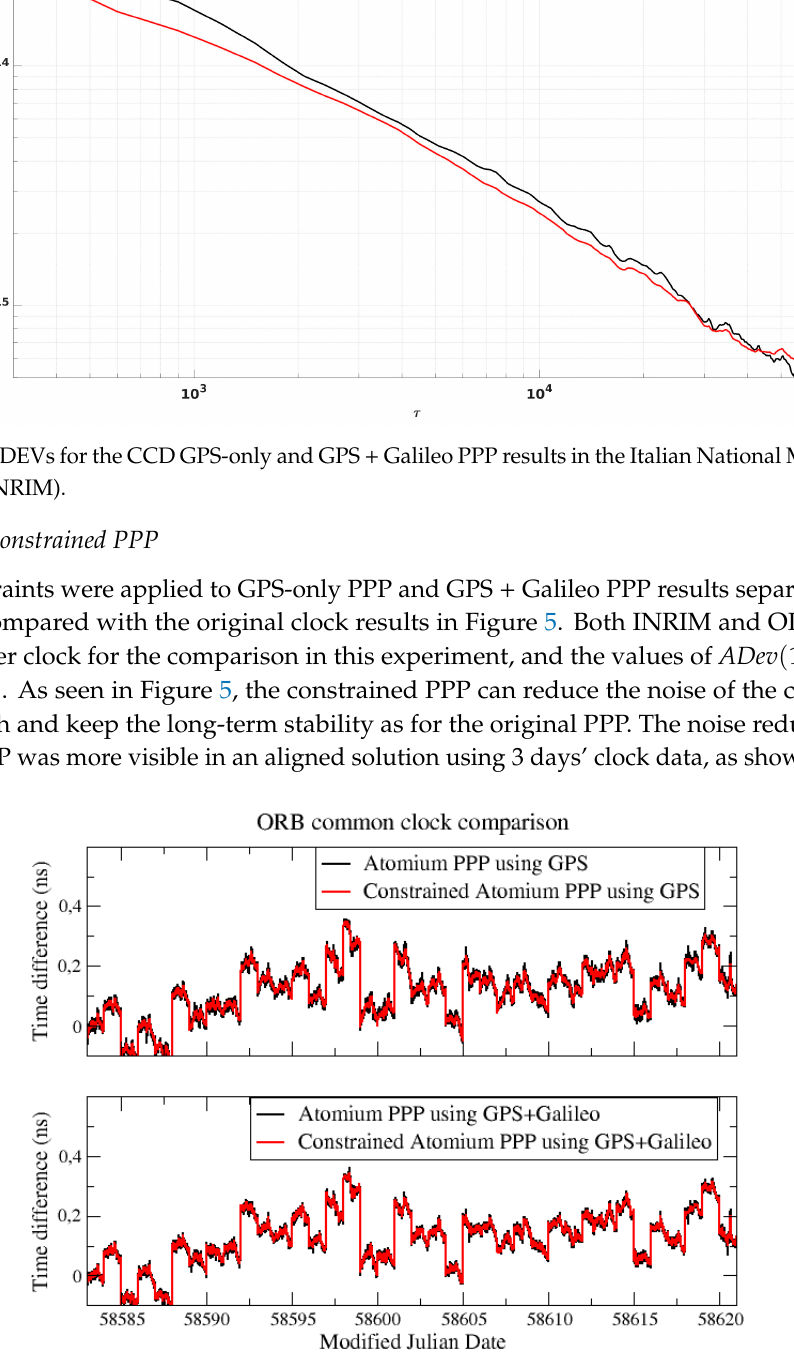
Figure 3. Allan DEViations (ADEVs) for the CCD global positioning system (GPS)-only and GPS + Galileo precise point positioning (PPP) results in the Observatory of Belgium (ORB) from Figure 2.